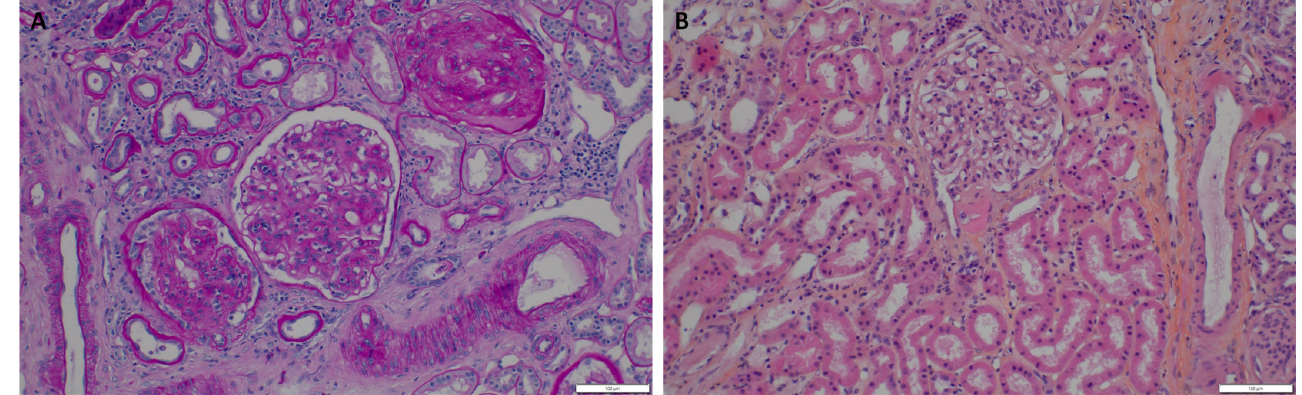
Figure 2. Renal histology (kidney biopsy performed at 11 gestational weeks). ( A ) Periodic acid Schiff staining. ( B ) Hematoxylin and eosin staining.